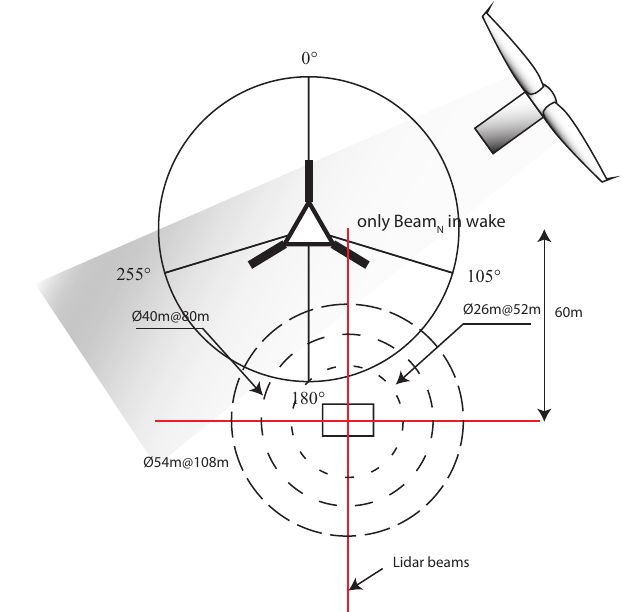
Figure 5. Only the North beam within the wake with 25% reduc- tion, The 0 ◦ represents the North and the Lidar beam N is calibrated with the north direction.